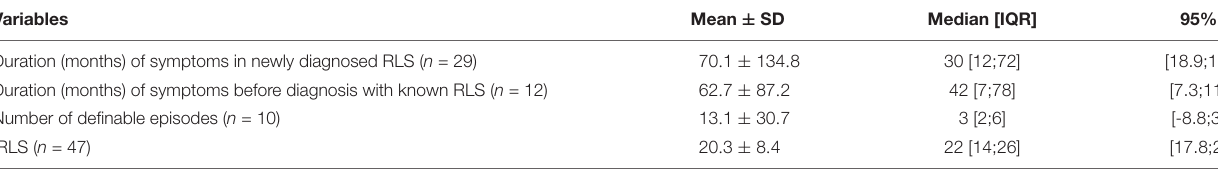
TABLE 3 | Restless legs syndrome (RLS) characteristics for variables measured on a continuous scale.